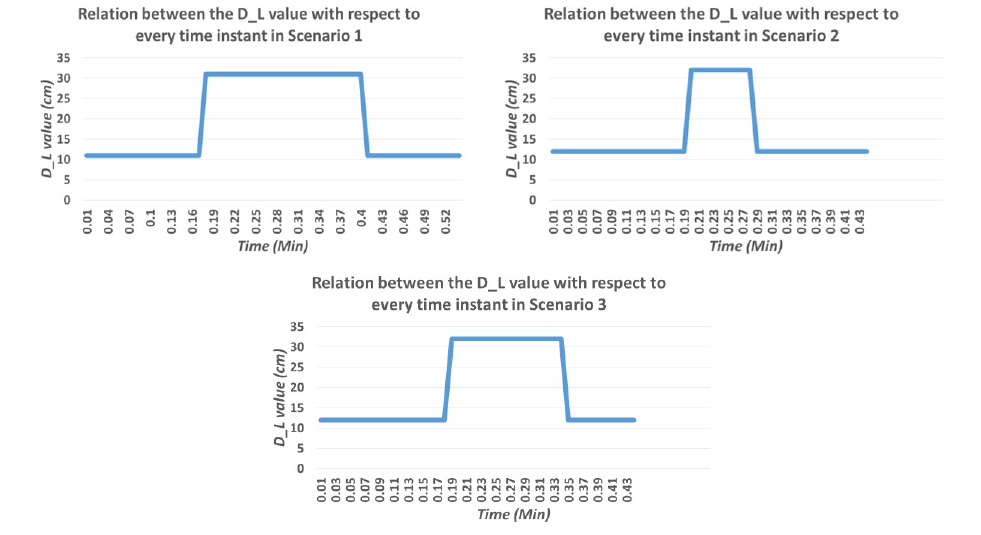
Figure 21. Time vs D L value curve in scenario 1 ( top left ), scenario 2 ( top right ), scenario 3 ( bottom ).